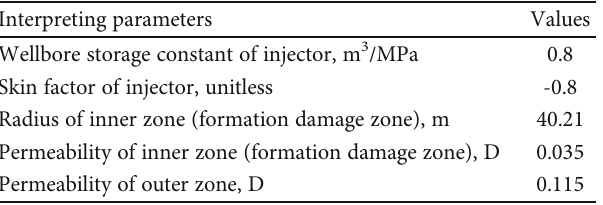
Table 3: Interpretation results generated from our model. Interpreting